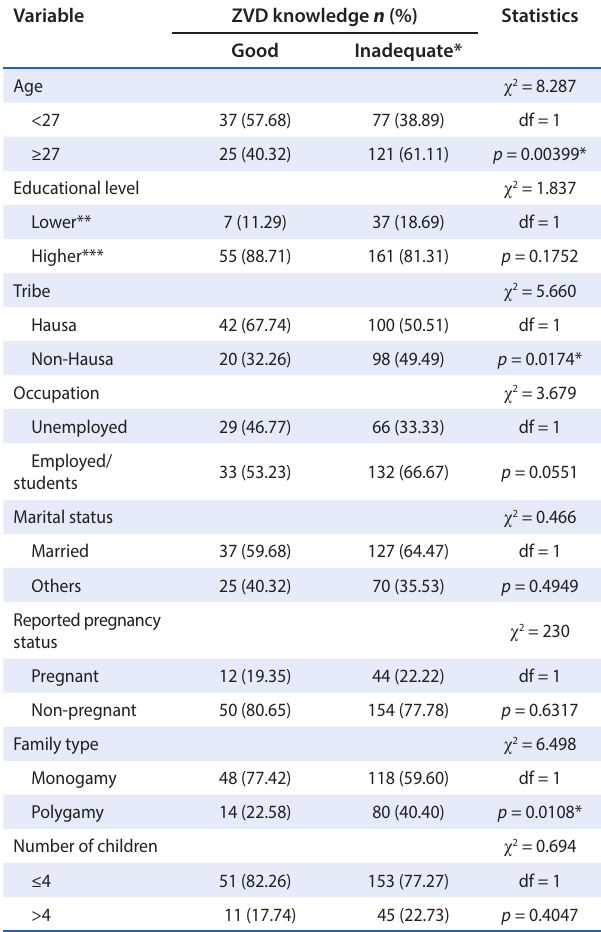
*Inadequate: poor and average knowledge. **Lower: none, Quranic and primary education. ***Higher: secondary and tertiary